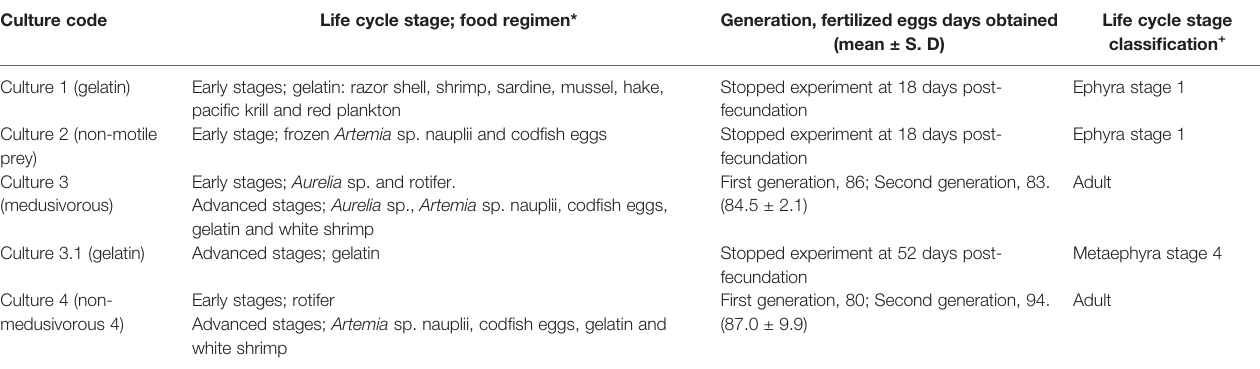
TABLE 1 | Food regimens according to the life cycle stages, post-fecundation days and life cycle classi fi cation at the end of each experiment. Culture code